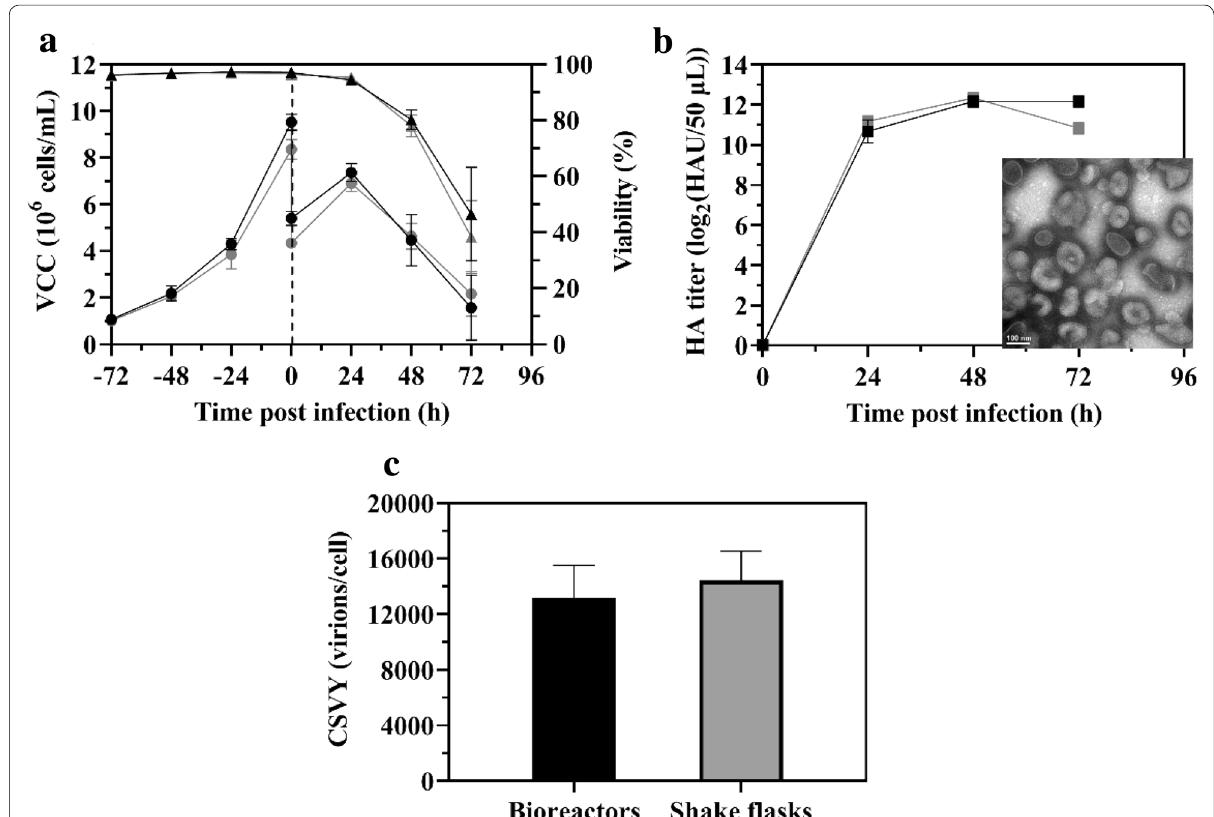
Fig. 5 MDCK cell growth and H9N2 virus production in stirred tank bioreactors ( n circle) and cell viability (black triangle) of MDCK cells in bioreactors (black) and shake flasks (gray). b HA titers of viruses produced by MDCK cells in bioreactors (black) and shake flasks (gray). The inset in the panel is a TEM picture of purified viruses harvested from one of the bioreactors. c The calculated cell‑specific virus yield of the viruses in bioreactors (black column) and shake flasks (gray column)